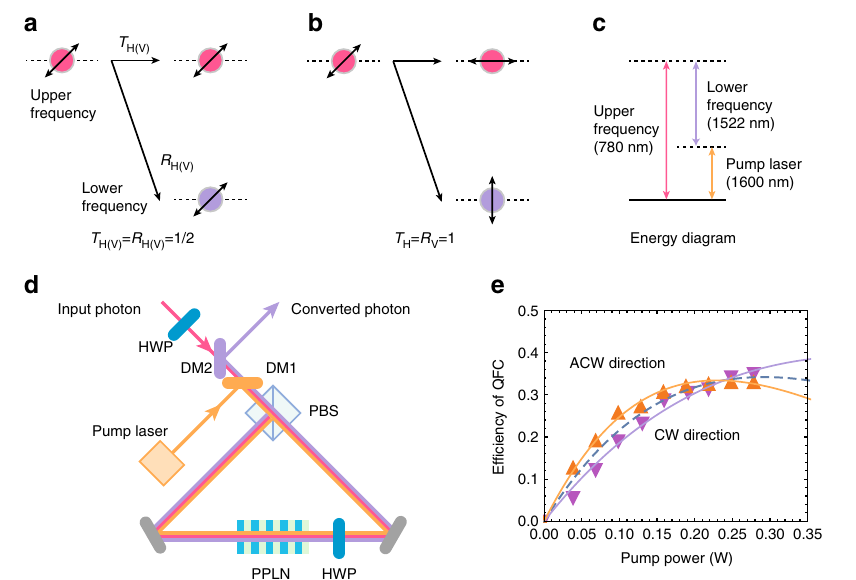
Fig. 1 QFC as a frequency-domain linear optics with the two polarization modes. a Concept of a non-polarizing frequency-domain half BS for T H(V) = R H(V) = 1/2. b A frequency-domain PBS for T = R = 1 and T = R = 0. c Energy diagram related to the QFC used in our experiment. The difference frequency H V V H generation of a photon from 780 nm (upper frequency) to 1522nm (lower frequency) is performed by using a strong pump light at 1600 nm. d The experimental setup of dual-polarization-mode QFC. Type-0 quasi-phase-matched PPLN crystal as a nonlinear optical medium which acts on only the V- polarized photons is installed in the Sagnac type interferometer. The detailed explanation of the QFC is in the main text. DM dichroic mirror, HWP half wave plate, PBS polarizing beamsplitter. e Conversion ef fi ciency from the front to the end of the QFC. It is measured by using classical laser light and a power meter. The error of the power meter was about 1% and they are smaller than the markers of data. Solid curves are fi tted to data for CW and ACW ffiffiffiffiffi p (cid:6) (cid:7) directions separately by using functions η , where P is the pump power. Parameters η max and g for CW(ACW) directions are estimated as gP sin 2 max 0.39 (0.33) and 5.8/W (10.7/W), respectively. A broken curve is fi tted to two data set together, resulting in η max = 0.34 and g =